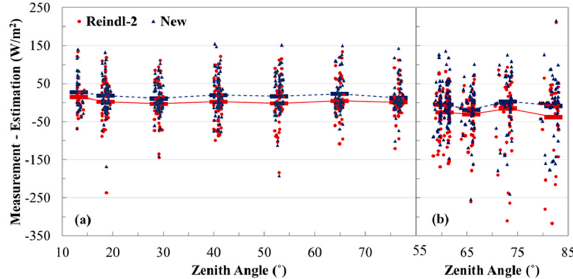
Figure 7. Effects of the solar zenith angle on errors for estimating the hourly DNI, in which the dotted and the solid lines indicate the averages of the Reindl-2 and the new models in each separate interval of the solar zenith angle, respectively: ( a ) June 2009; and ( b ) December 2009.